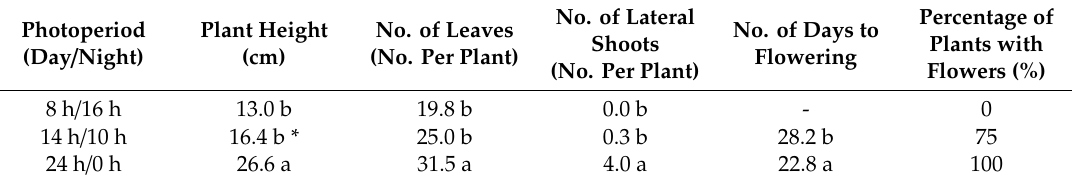
Table 3. E ff ects of photoperiod on growth of petunia grown at under blue light emitting diode panels (70 µ mol m − 2 s − 1 at 25 ◦ C) for 4